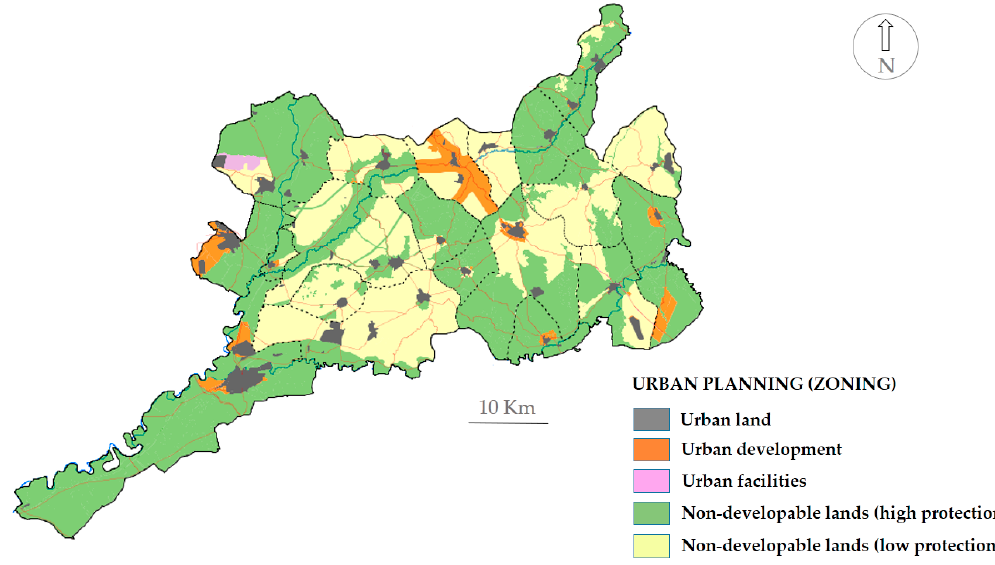
Figure 5. Land use in the urban planning of the 21 municipalities which make up the study area.